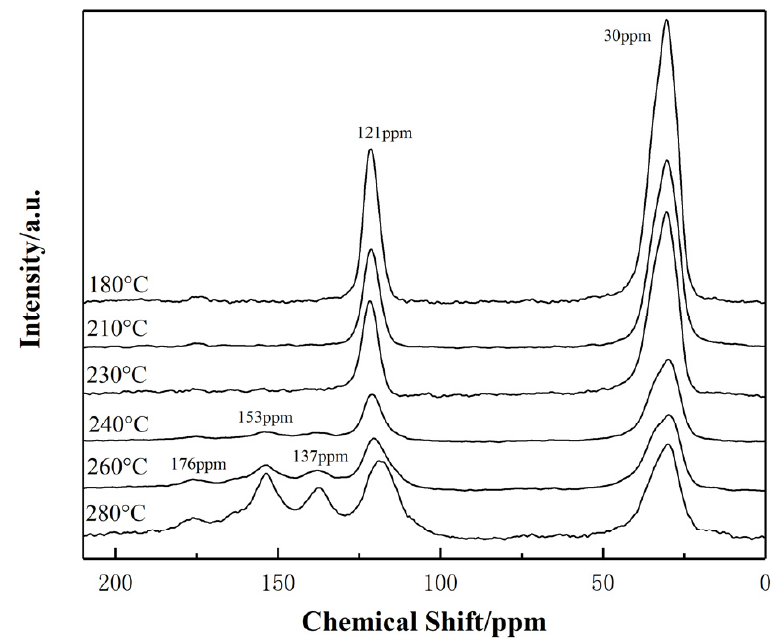
Figure 6. 13 C-NMR spectra of PAN fibers stabilized at 180–280 °C.